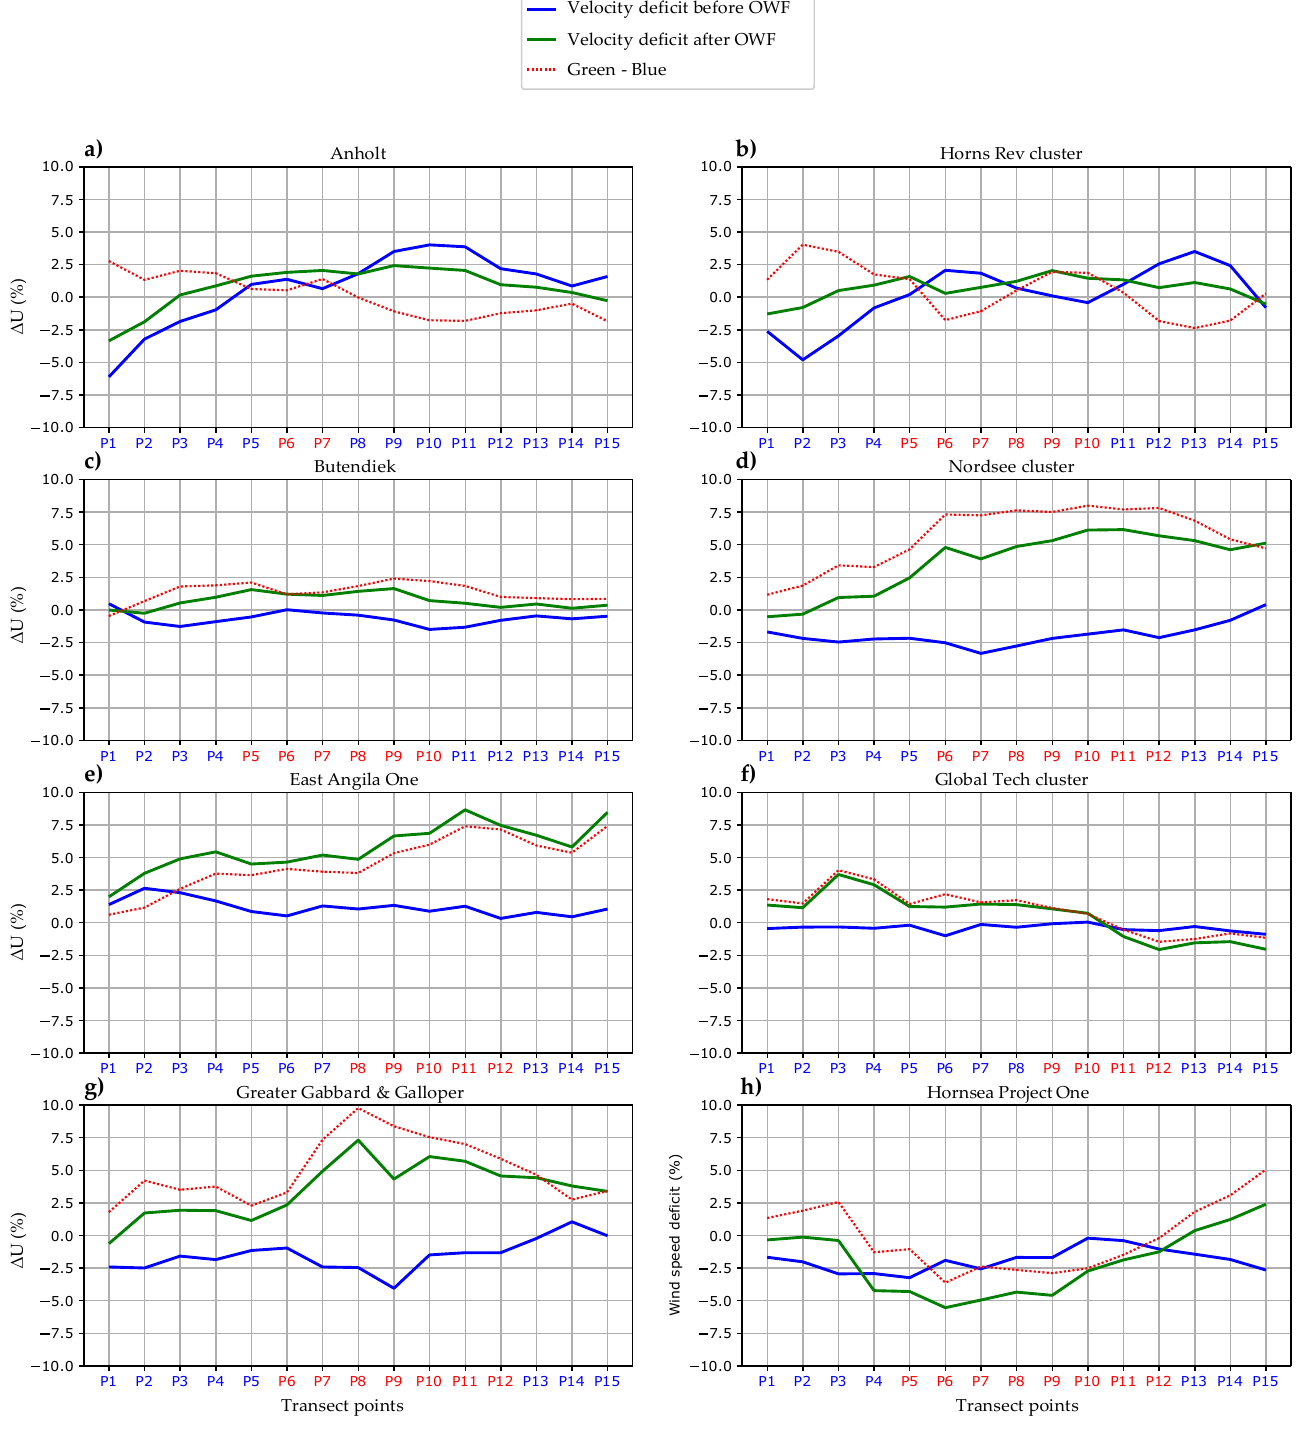
Figure 9. Velocity deficit ( 𝛥𝑈) for southerly winds over the OWFs and clusters. See Figure 5 for the definitions of lines. Note that the figure axes are different than for the corresponding plots for westerly and easterly winds as we have chosen to match the layout of transects in Figure 3. ( a ) Anholt; ( b ) Horns Rev cluster; ( c ) Butendiek; ( d ) Nordsee cluster; ( e ) East Anglia One; ( f ) Global Tech cluster; ( g ) Greater Gabbard & Galloper; ( h ) Hornsea Project One. 3.4. Horizontal Coastal Wind Speed Gradient Variation before OWFs